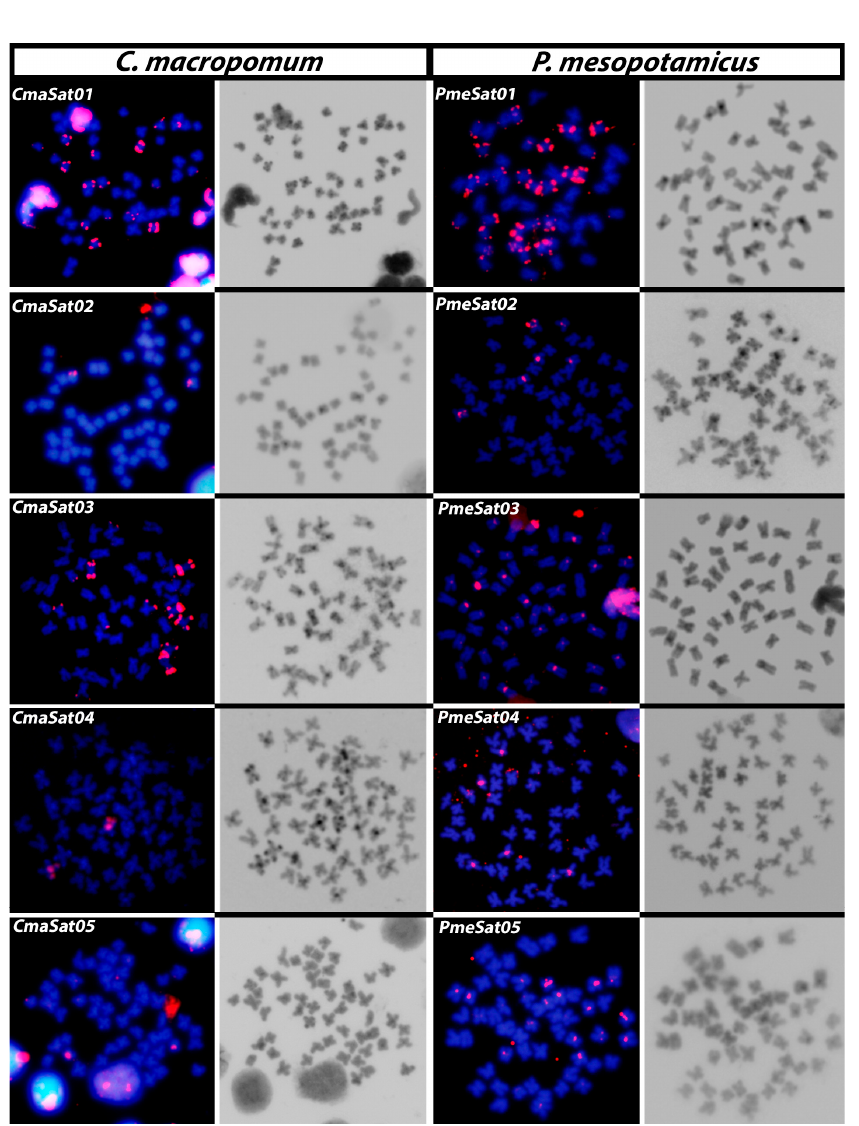
Figure 1. Metaphase plates of C. macropomum and P. mesopotamicus , highlighting the chromosomal location of the five most abundant satDNAs in each species and the patterns of constitutive hetero-